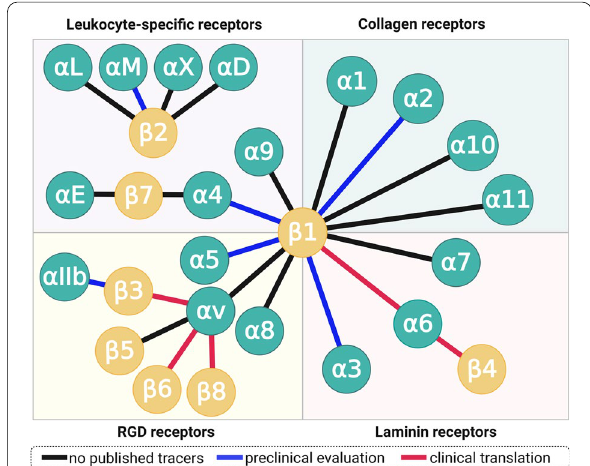
Fig. 1 The integrin receptor family: Integrin subunits and the known dimers formed. Each connecting line represents one integrin. Although small-molecule ligands have been developed for many subtypes, radiolabeled derivatives thereof were reported only for a fraction of integrins (blue and red lines). "Clinical translation" encompasses all hitherto reported applications of such radiopharmaceuticals in humans, i.e., not only clinical trials but also single cases and small